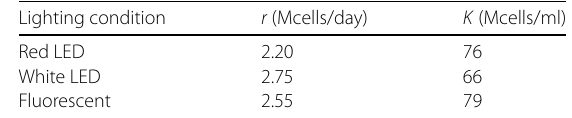
Table 1 The experimental data of algae cultivation under different lighting